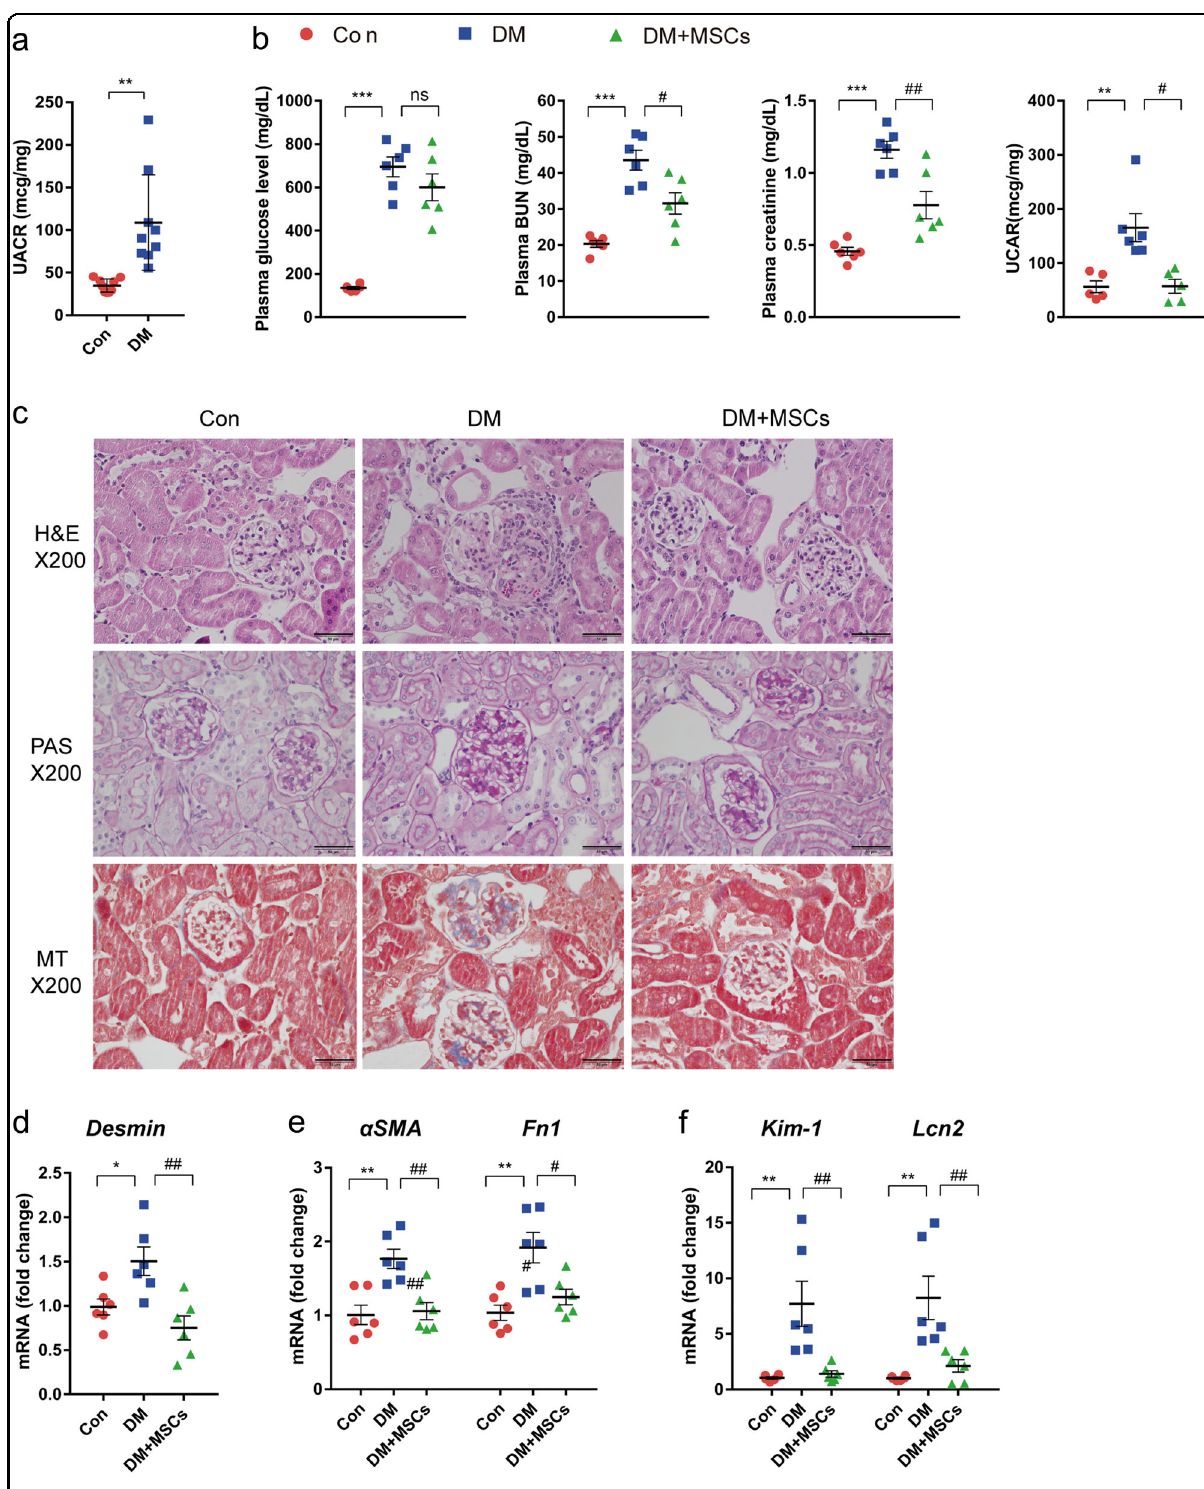
Fig. 1 MSC treatment prevented the progression of diabetic nephropathy. Diabetic mice were treated with vehicle or MSCs 5, 9, and 13 weeks after STZ injection and sacri fi ced at 24 weeks. a Albuminuria, de fi ned by the UACR, was markedly increased in diabetic mice 4 weeks after STZ injection. b Changes in plasma glucose, BUN, creatinine, and UACR levels in diabetic mice treated with or without MSCs. c Representative H&E, PAS, and MT staining of kidney sections. Scale bars, 50 µm. d – f MSC treatment prevented renal damage in diabetic mice. The mRNA levels of Desmin , a marker of podocyte injury d ; α -SMA , and Fn1 , markers of fi brosis e ; and Kim-1 and Lcn2 , markers of tubular epithelial injury f . Con, control non-diabetic CD1 mice; DM, diabetic CD1 mice; DM + MSCs, diabetic CD1 mice with MSC treatment. Data show the means ± SEMs of 6 – 9 mice. * P < 0.05, ** P < 0.01, and *** P < 0.001 versus Con; # P < 0.05, and ## P < 0.01 versus